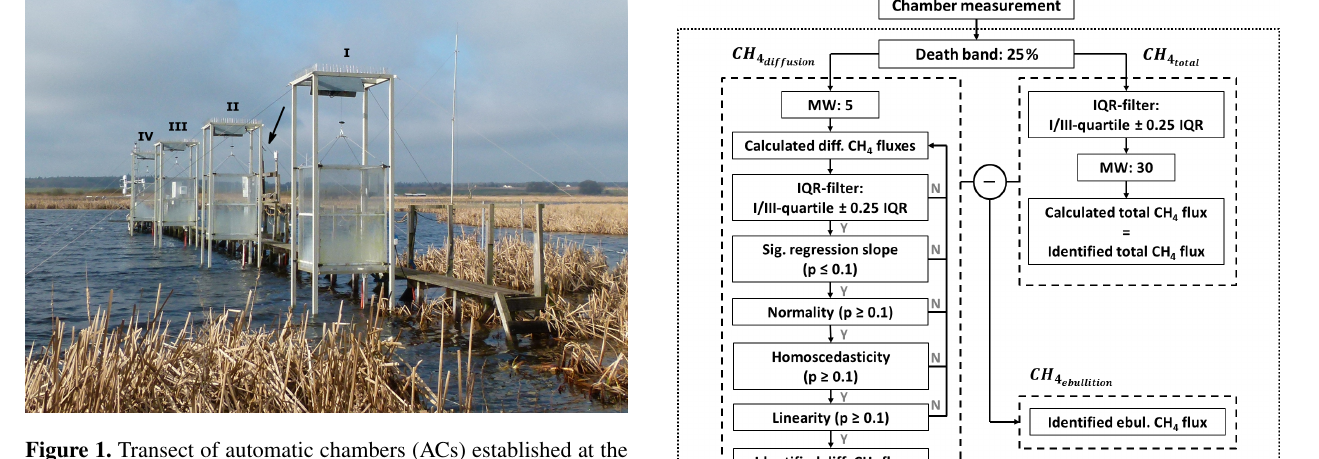
Figure 1. Transect of automatic chambers (ACs) established at the measurement site. The arrow indicates the position of the climate station near chamber II.